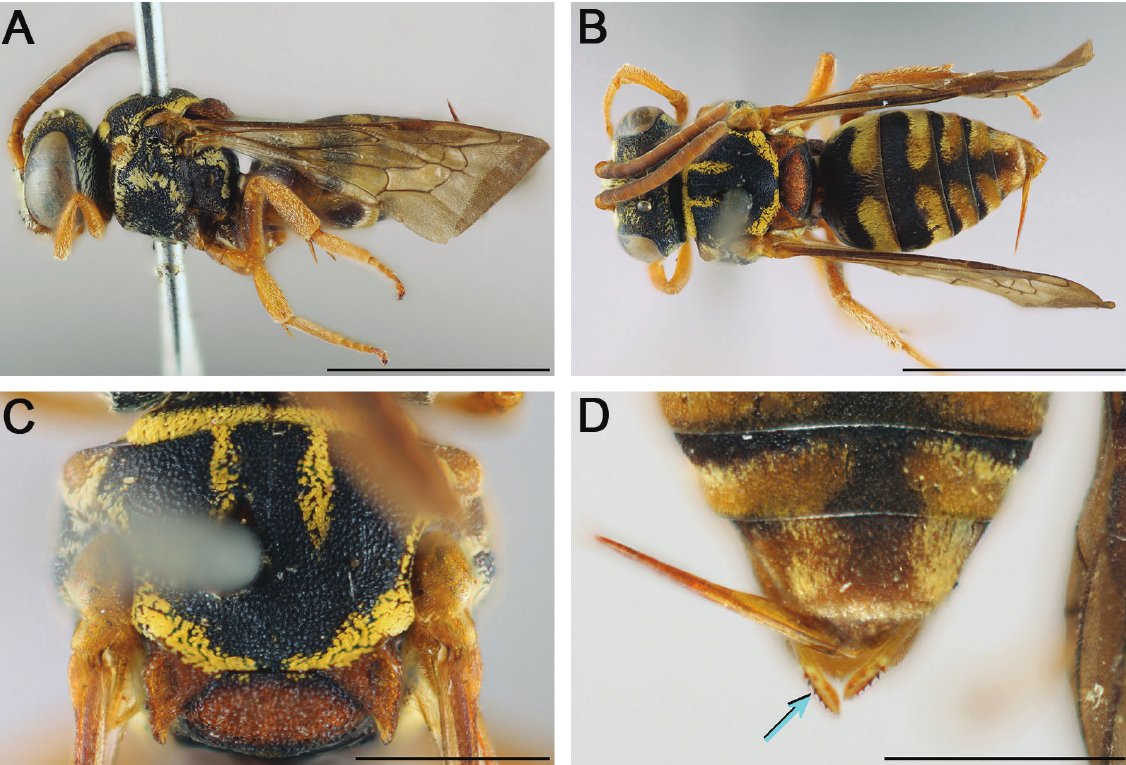
Fig. 9. Epeolus danieli (Genaro, 2014) comb. nov., holotype, ♀ (MNHNSD 18.107). A . Habitus, lateral view. B . Habitus, dorsal view. C . Mesosoma, dorsal view. D . Posterior part of metasoma, dorsal view (blue arrow indicates process of S6). Images courtesy of G. de los Santos, MNHNSD. Scale bars: A–B = 3 mm; C–D = 1